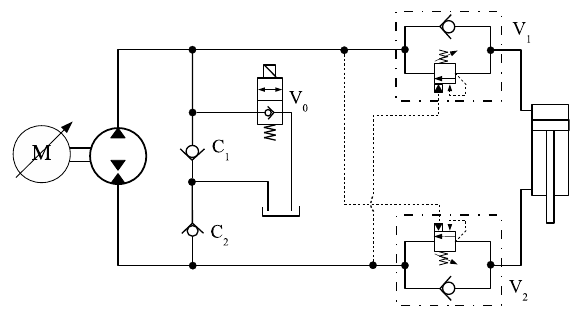
Figure 22. Addition of inline check-valves.